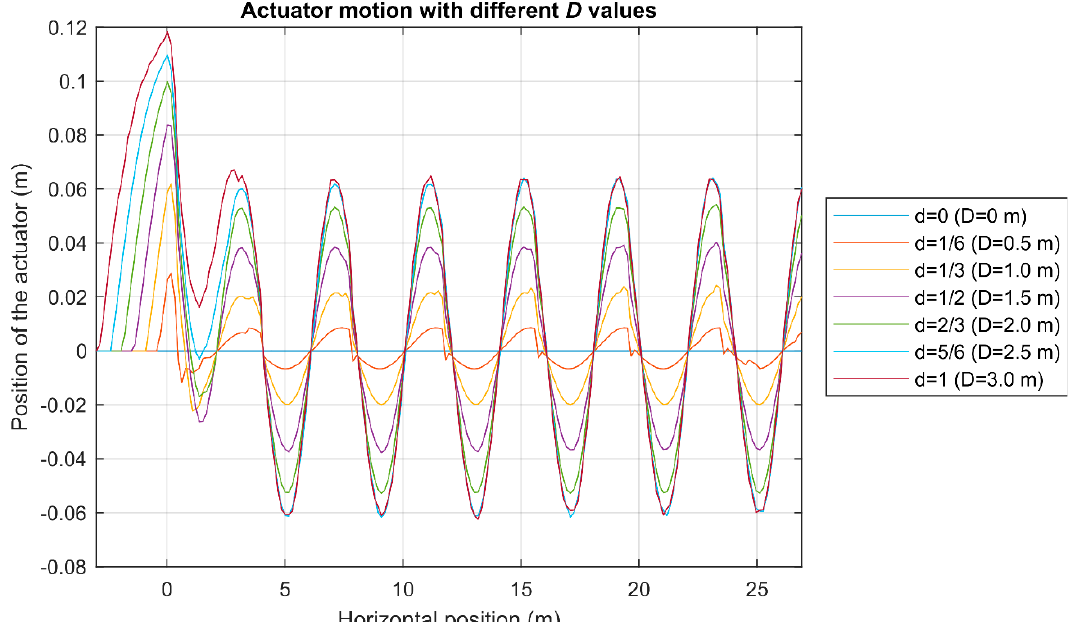
Figure 9. Kinematics of the vehicle when traveling through the ground profile 1.